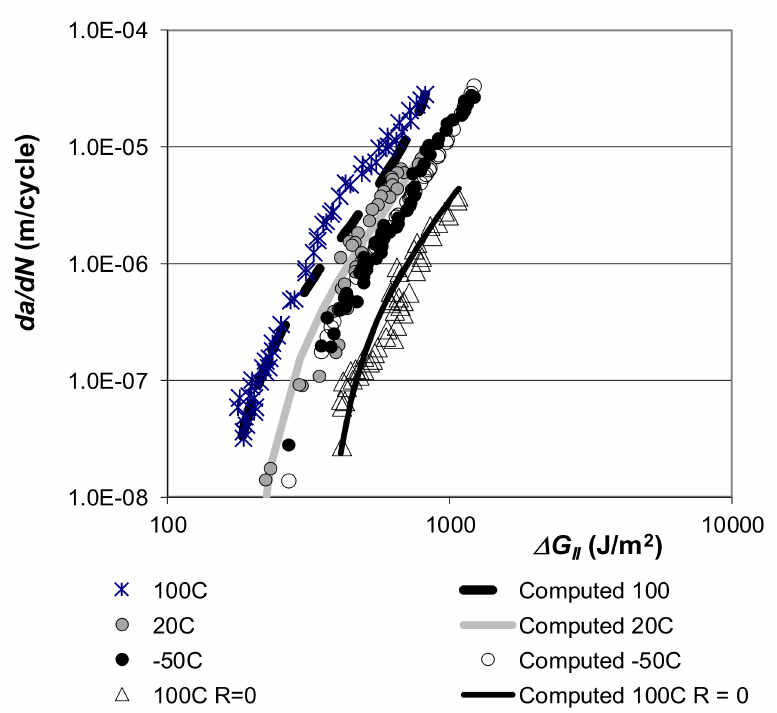
Figure 3. The measured [72] and computed [60] R = –1 and R = 0 da / dN versus ∆ G II curves for “FM300K”. (Where da / dN is the fatigue crack growth rate, with a being the crack length and N the number of fatigue cycles. The term ∆ G is the range of the applied strain-energy release-rate in the fatigue cycle, as defined by ∆ G = G max − G min ; where G max and G min are the maximum and minimum values of the applied energy release-rates in the fatigue cycle, respectively).